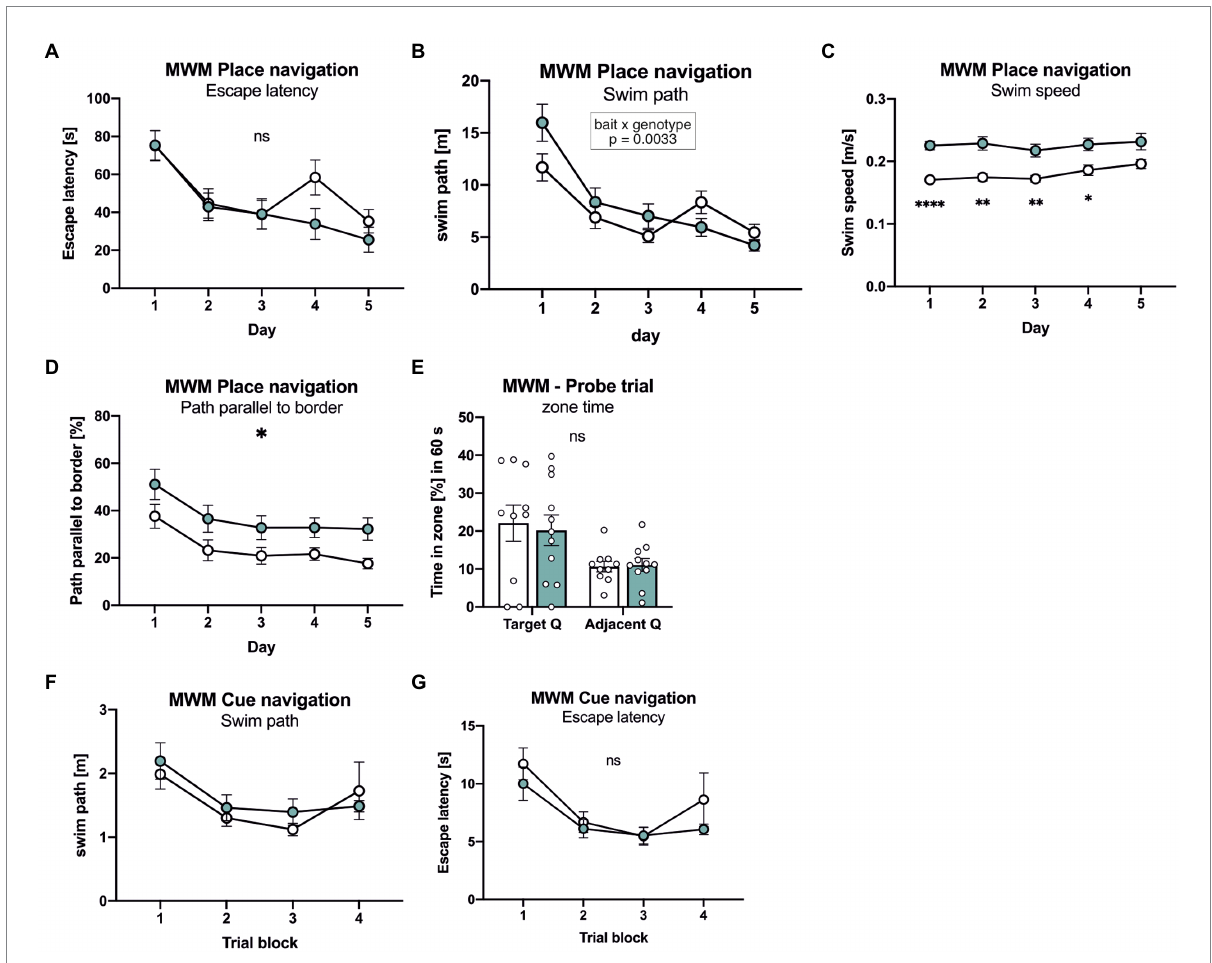
FIGURE 4 APLP1-KOs show no deficits in spatial learning and spatial reference memory. (A) : MWM, escape latency. During place navigation training, both genotypes showed evidence of learning. [geno F (1, 19) = 0.6471 ns; day F (3.455, 65.64) = 22.86, p < 0.0001; day × geno F (4, 76) = 2.228 ns]. (B) : Morris Water Maze (MWM), swim path. Both genotypes shortened their swim path over trials. Of note, wildtype controls showed a reversal effect while APLP1-KOs did not [geno F (1, 19) = 0.5215 ns; day F (2.871, 54.54) = 29.73, p < 0.0001; day × geno F (4, 76) = 4.321, p = 0.0033]. (C) : MWM, Swim speed of APLP1-KO animals was higher than in wildtype controls. [geno F (1, 19) = 20.47, p = 0.0002; day F (3.020, 57.39) = 3.562, p = 0.0194; day × geno F (4, 76) = 1.113 ns]. (D) : MWM, path parallel to the border. APLP1-KOs spent more time parallel to the border of the basin than wildtype